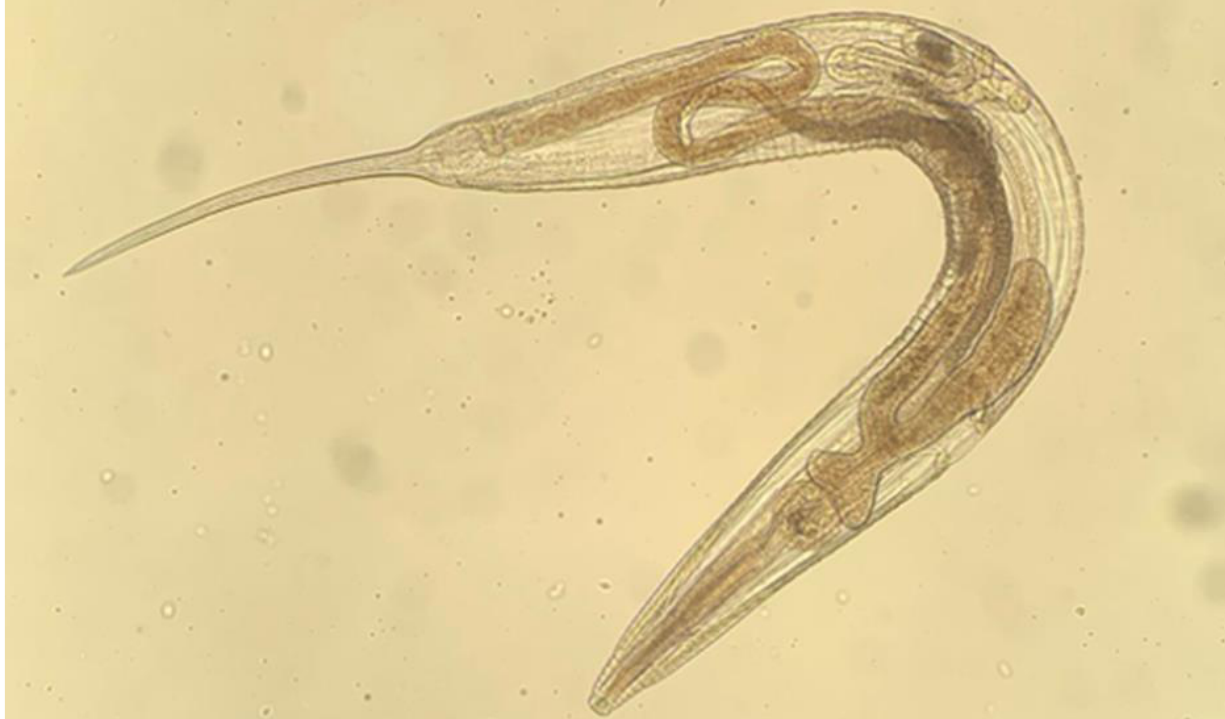
Figure 5. Leidynema appendiculata image pinworm found in the hindgut of dubia roaches ( Blaptica dubia) at The North Carolina Museum of Natural Science (Raleigh, NC, USA). Image taken at 400× during pre-treatment necropsy.